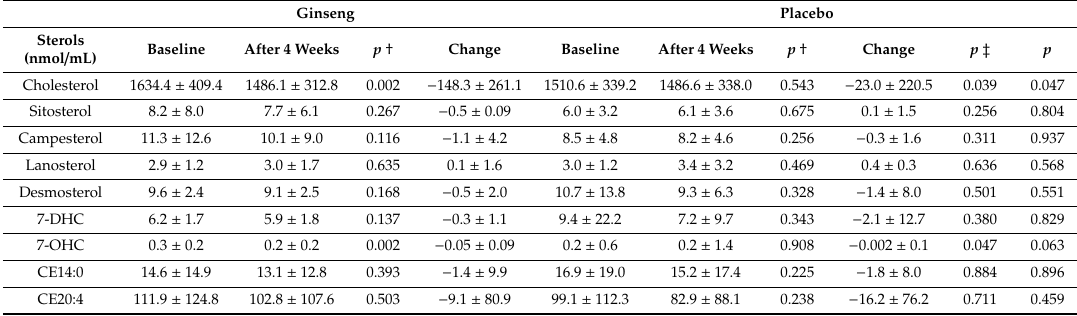
Table 3. Changes in metabolic parameters and cholesterol metabolites in the ginseng and placebo groups before and after the 4-week intervention. Ginseng Placebo Sterols † Change Baseline After4Weeks p † Change p ‡ (nmol / mL) Baseline After4Weeks p